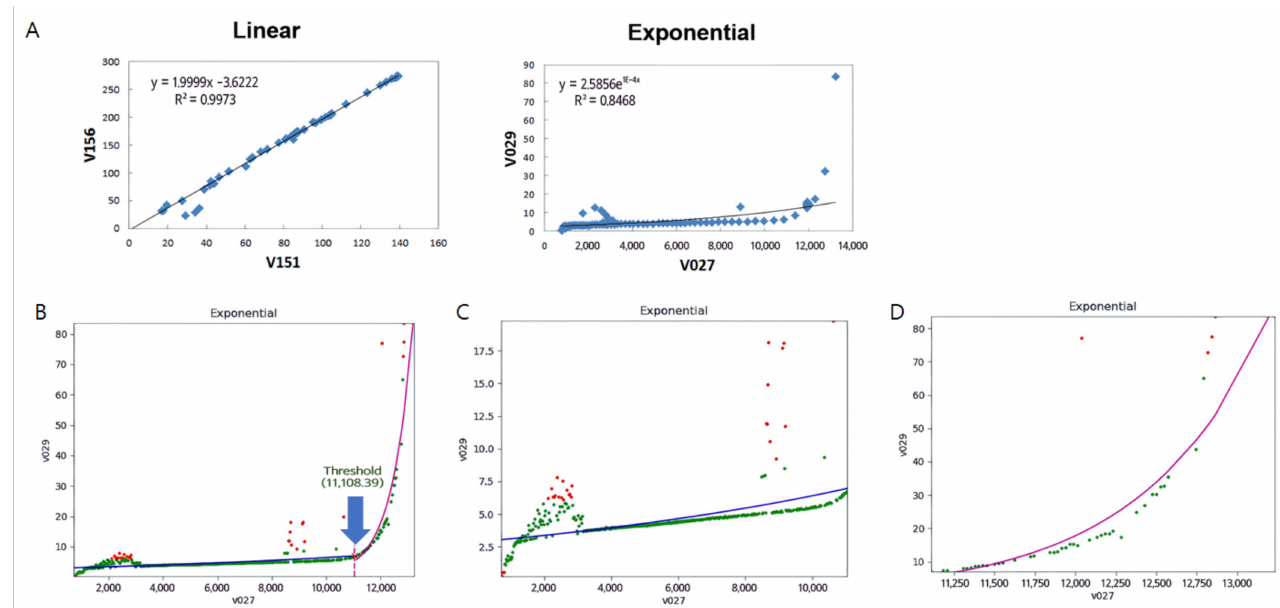
Figure 4. Regression analysis to show the correlation between two sensors. ( A ) Grouping two sensors to observe whether they were correlated or not. Meaningful relationships in the semiconductor manufacturing process were linear and exponential. ( B ) Support vector regression method for the fault detection in the exponential relationship. This relationship could be divided into two sectors based on its threshold. The regression analysis was applied to the respective sector, ( C ) before and ( D ) after the threshold